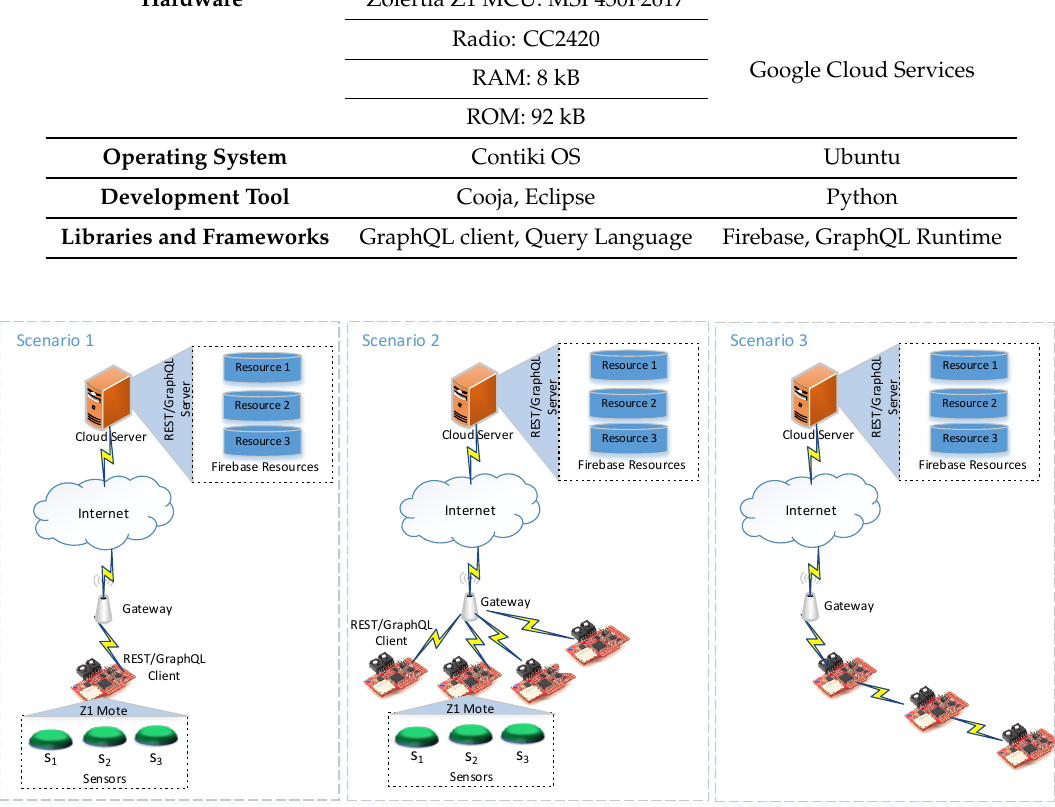
Figure 9. Experimental scenarios for performance analysis of the proposed